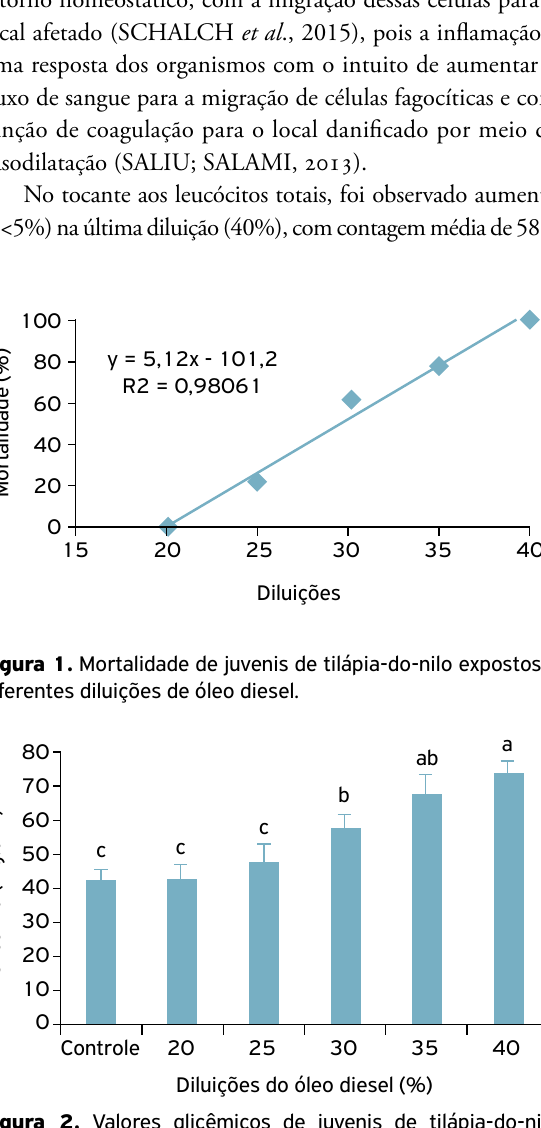
Figura 2. Valores glicêmicos de juvenis de tilápia-do-nilo expostos a diferentes diluições de óleo diesel. Valores nas barras (média ± desvio padrão) seguidas de letras diferentes apresentam diferença estatística pelo teste Tukey